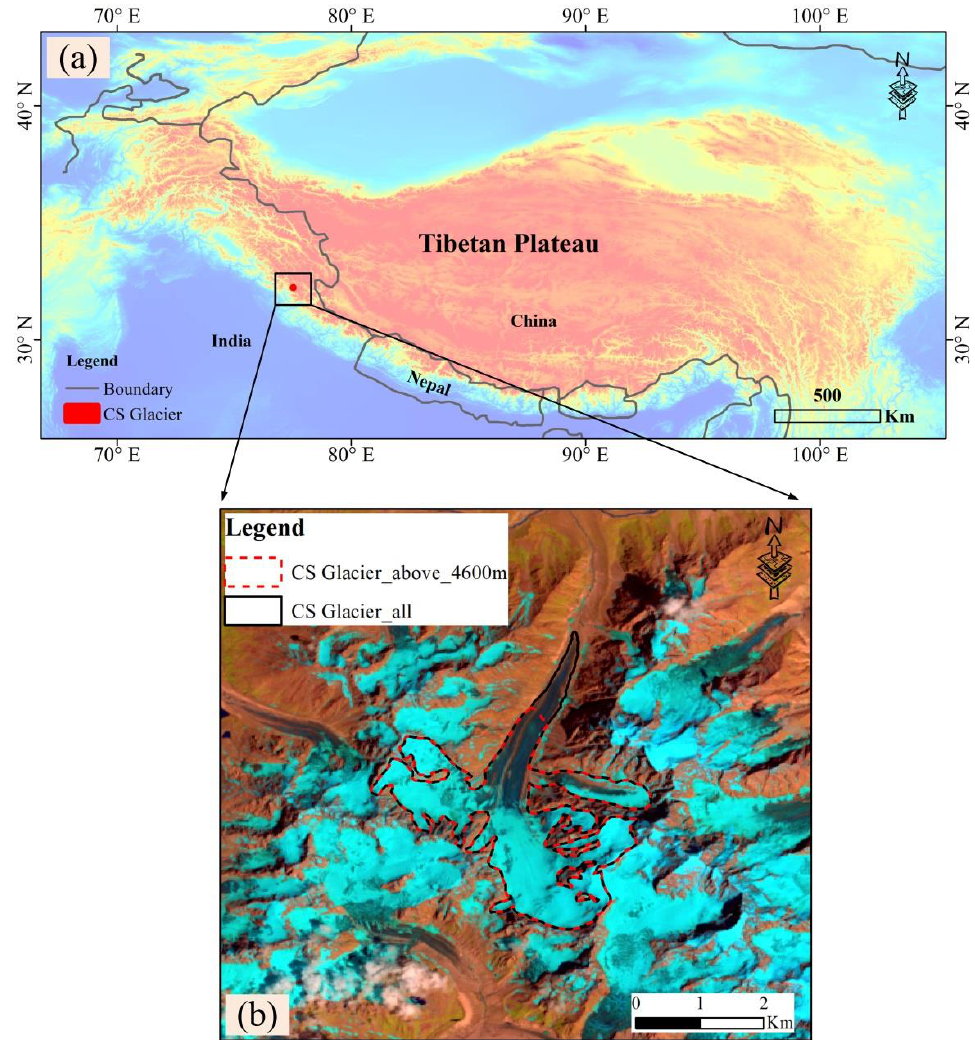
Figure 1. ( a ) Geographical location of the Chhota Shigri glacier in the western Himalayas. ( b ) False-color composite imagery (SWIR, NIR and green) from Landsat OLI acquired on 11 August 2014. Outlines of the entire Chhota Shigri glacier and the debris-free regions are shown with black solid and red dashed lines, respectively.